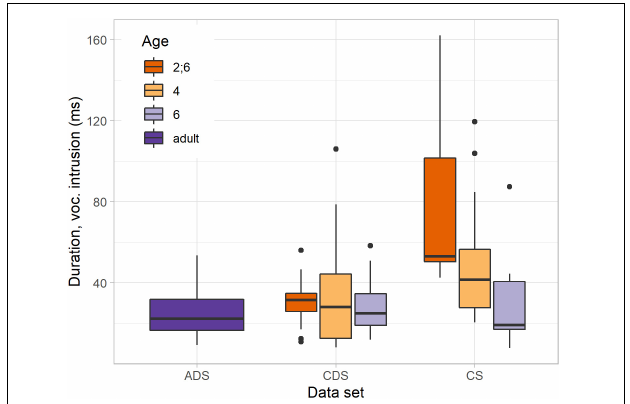
FIGURE 3 | Duration of vocalic intrusion in ADS, in CDS to different age groups (2;6, 4, and 6) and in CS in different age groups (2;6, 4, and 6).